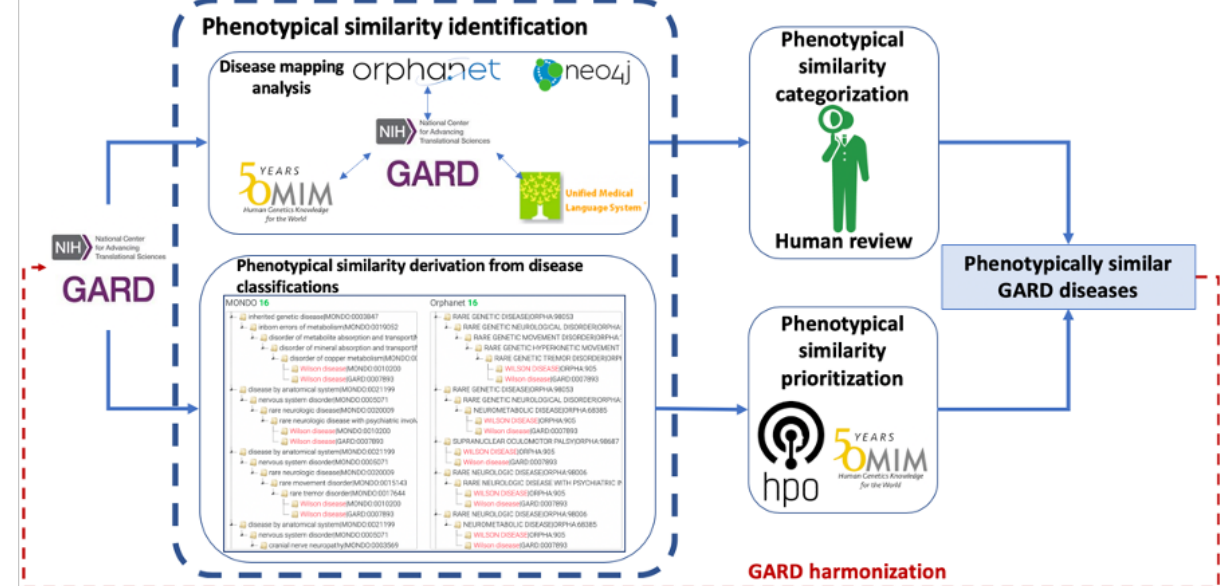
Figure 1. The architecture of phenotypically similar GARD disease